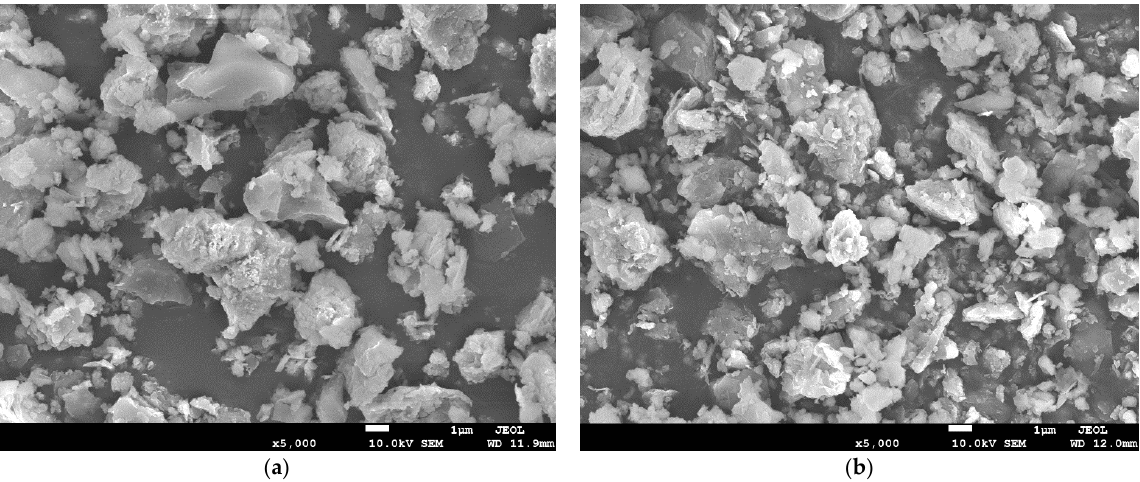
Figure 4. Scanning electron microscopy (SEM) analysis of silane-treated and untreated FA. ( a ) Unmodified FA; ( b ) FA treated with ATPS.